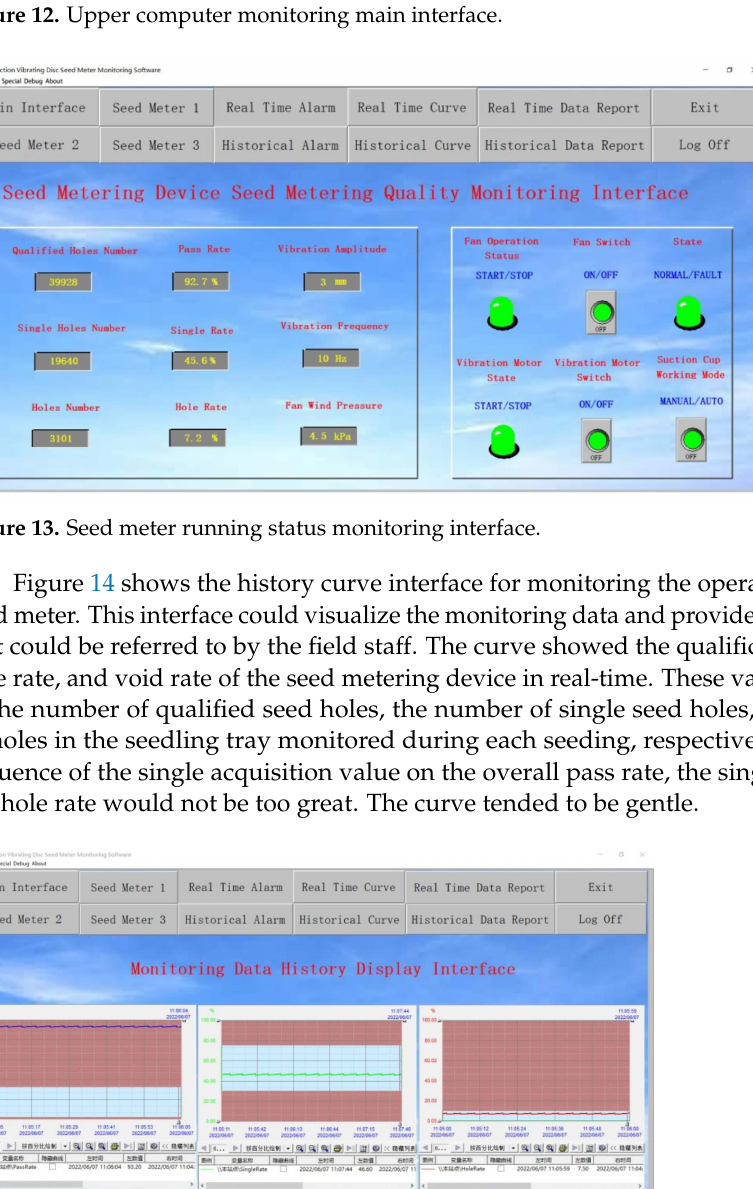
Figure 12. Upper computer monitoring main interface.